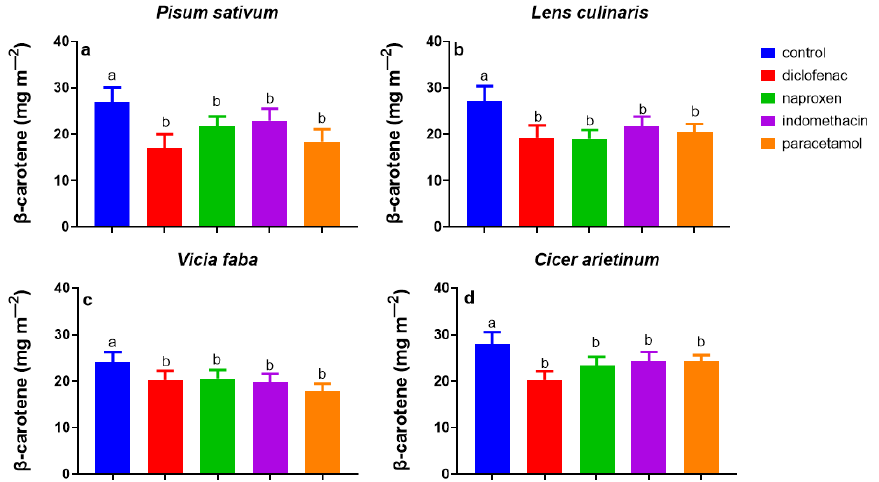
Figure 7. β -carotene concentration from Pisum sativum ( a ), Lens culinaris ( b ), Vicia faba ( c ), and Cicer arietinum ( d ). Plants in 0.5 L pots filled with commercial garden soil were treated by watering 100 mL of 0.5 mg L − 1 NSAIDs every second day over a total of 20 days. The values are averages of four independent measurements. Data sharing different letters are significantly different ( p < 0.05), while data sharing the same letters are not significantly different ( p >